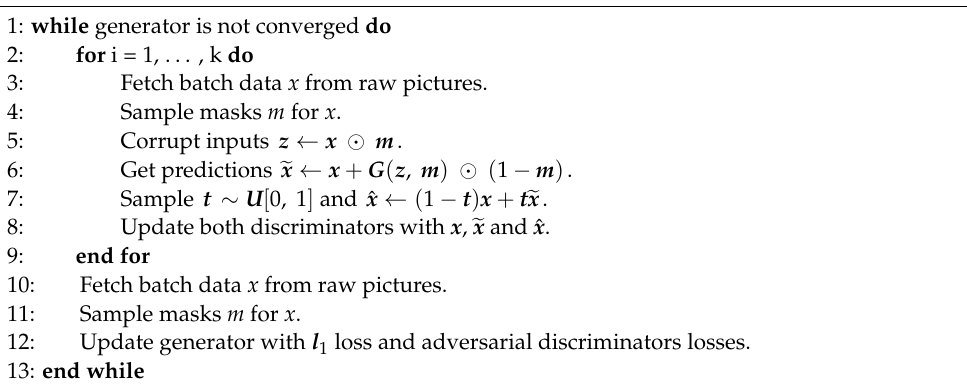
Algorithm 1. Training Process of Generative Adversarial